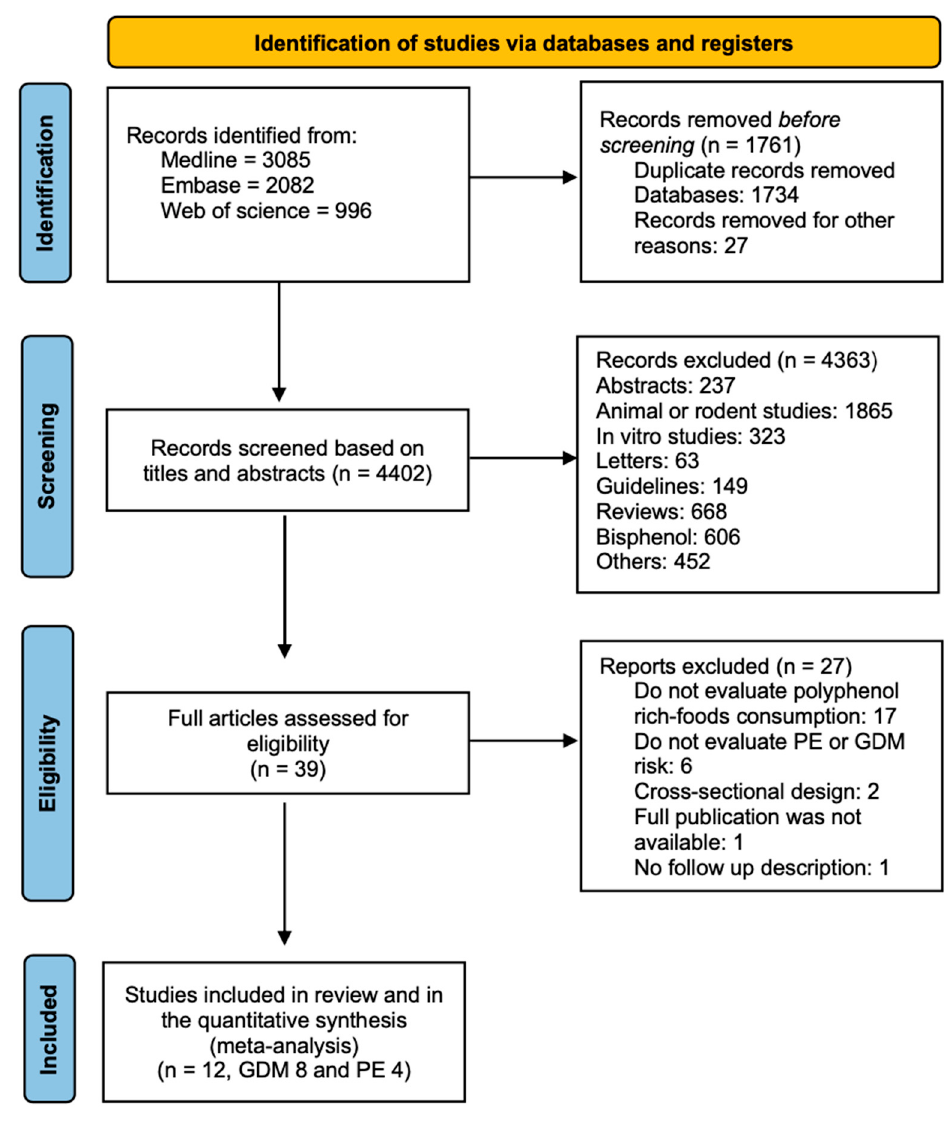
Figure 1. PRISM Flowchart for study selection. PRISMA, Preferred Reporting Items for Systematic Reviews and Meta-Analysis.